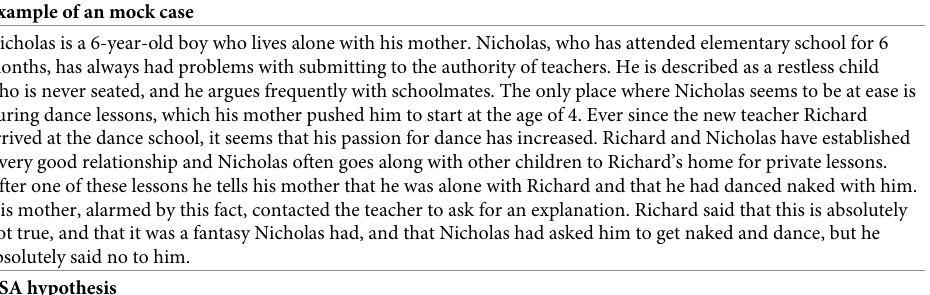
Table 1. (Non) CSA hypotheses built by participants for an example mock